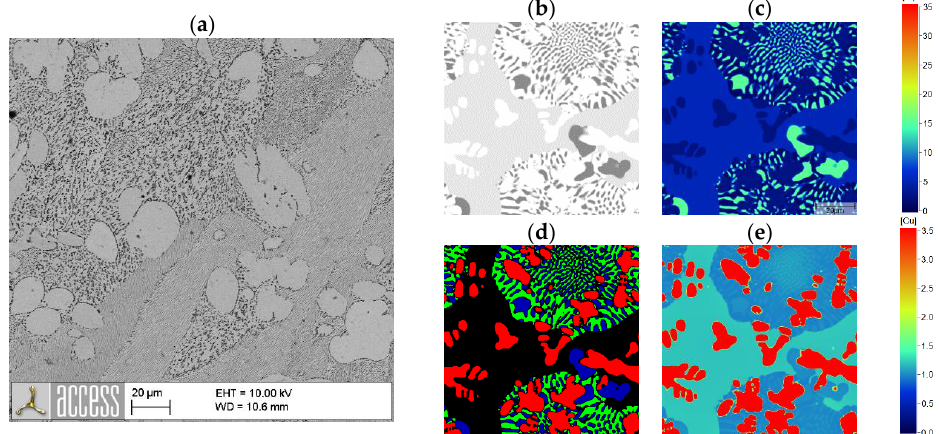
Figure 7. ( a ) Microstructure of ZnAl5.5Cu4 in BSE contrast. Simulated microstructure of ZnAl5.5Cu4; ( b ) Al (grey scale, matched contrast), ( c ) Al concentration (wt.%), ( d ) phases (η green, β blue, ε red) and ( e ) Cu concentration (wt.%). Size of the 2D plane: 100 µm × 100 µm.